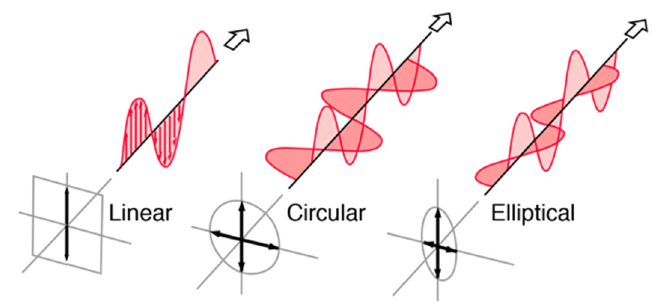
Figure 2. Types of polarization [17].